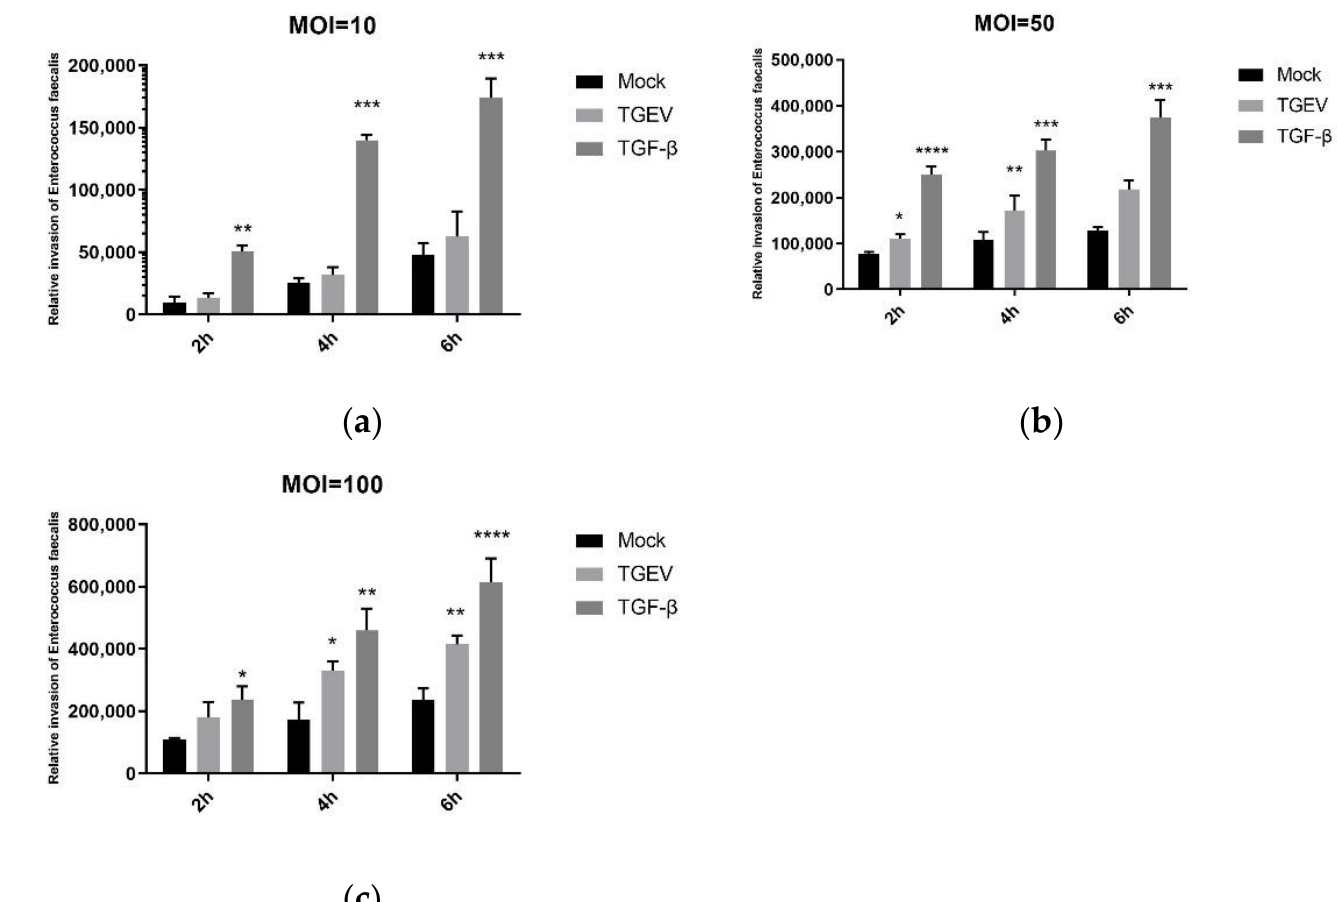
Figure 9. Invasion of IPEC-J2 cells by E. faecalis at different infection rates and time points. ( a ) MOI = 10; ( b ) MOI = 50; ( c ) MOI = 100. * p < 0.05, ** p < 0.01, *** p < 0.001, **** p < 0.0001